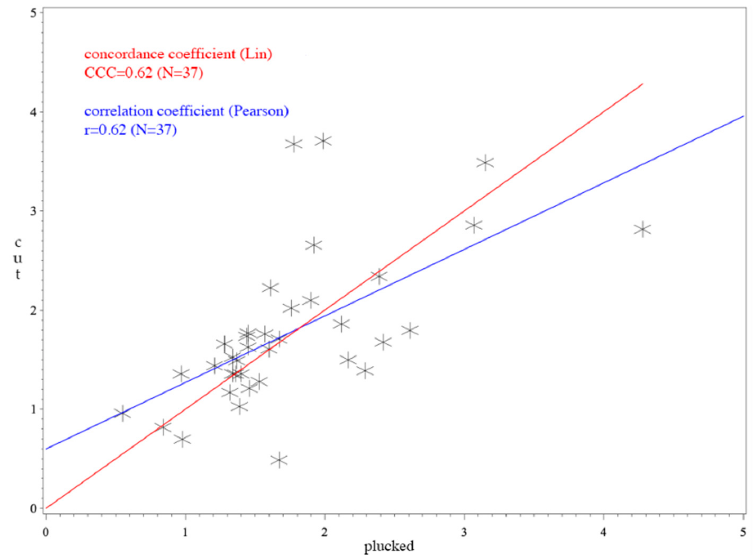
Figure 1. Concordance correlation coefficient (CCC) and Pearson’s correlation coefficient of Anas ; p -value for Pearson’s correlation coefficient: p = 0.6111 × 10 − 6 ; the x-axis shows the corticosterone values of plucked feathers. The y-axis represents the values of cut feathers. The red line illustrates the concordance coefficient. The correlation coefficient is expressed in the blue line.